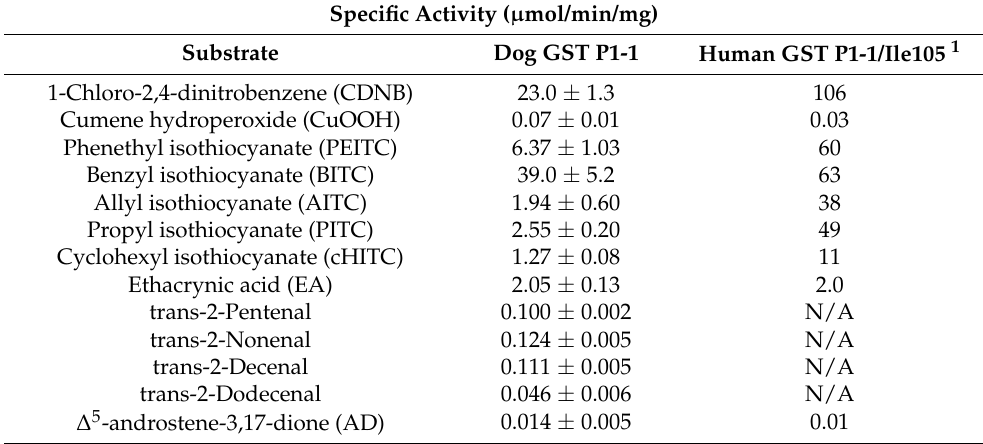
Table 1. Comparison of specific activities of dog GST P1-1 and human GST P1-1 with alternative